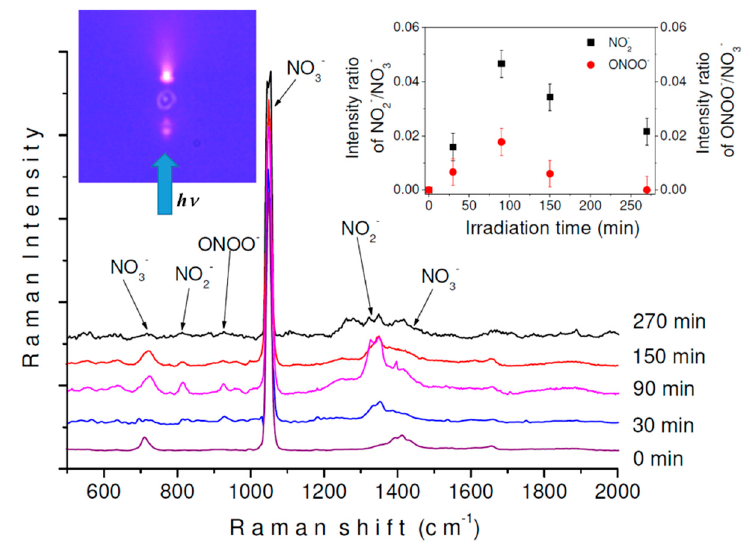
Figure 5. Raman spectra of a microdroplet of aqueous NaNO 3 obtained after different times of UV light irradiation (254 ± 25 nm) using an excitation line of 532 nm. ( Left inset ) Photograph of top capture of the particle during the irradiation process. ( Right inset ) Intensity of NO 2 − / NO 3 − and ONOO − / NO 3 − ratios as a function of the irradiation